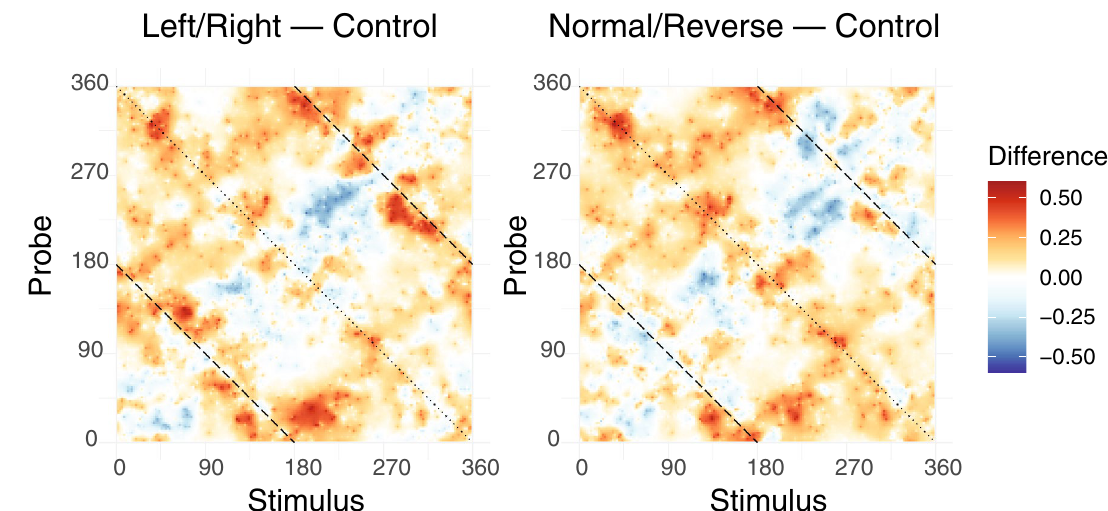
Figure 3. Difference in visual change detection probability, relative to the control condition. The left figure shows the probability of reporting a change in the condition trained in left/right faults, minus the corresponding probability for the control condition. Hence positive values (warm colors) indicate a stimulus-specific increase in change detection probability, while negative values (cool colors) indicate a decrease in change detection probability. The right figure shows the normal/reverse training condition relative to the control condition. The dashed and dotted lines correspond to “mirror stimuli” (see main text). (Figure generated using R version 4.0.3 and Adobe Illustrator